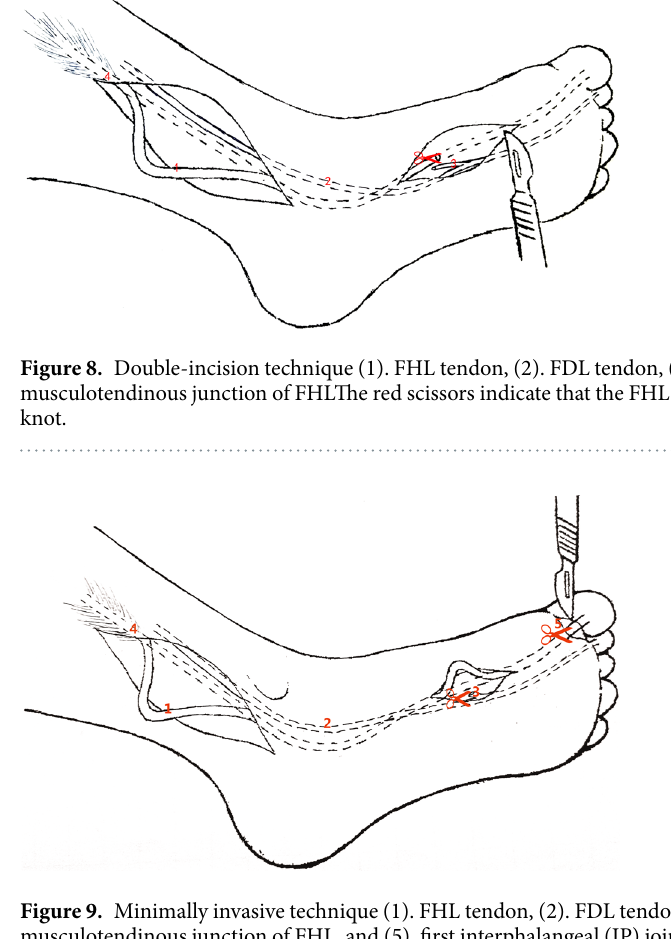
The tendinous connections between the FHL and FDL were classified using a modified classification sys- tem 19,20 . Type I describes an attachment branching from the FHL tendon proximally to the FDL tendon Type II describes a crossed connection; Type III describes a proximal to distal connection of the FDL to the FHL; and Type IV describes no connection between the tendons.